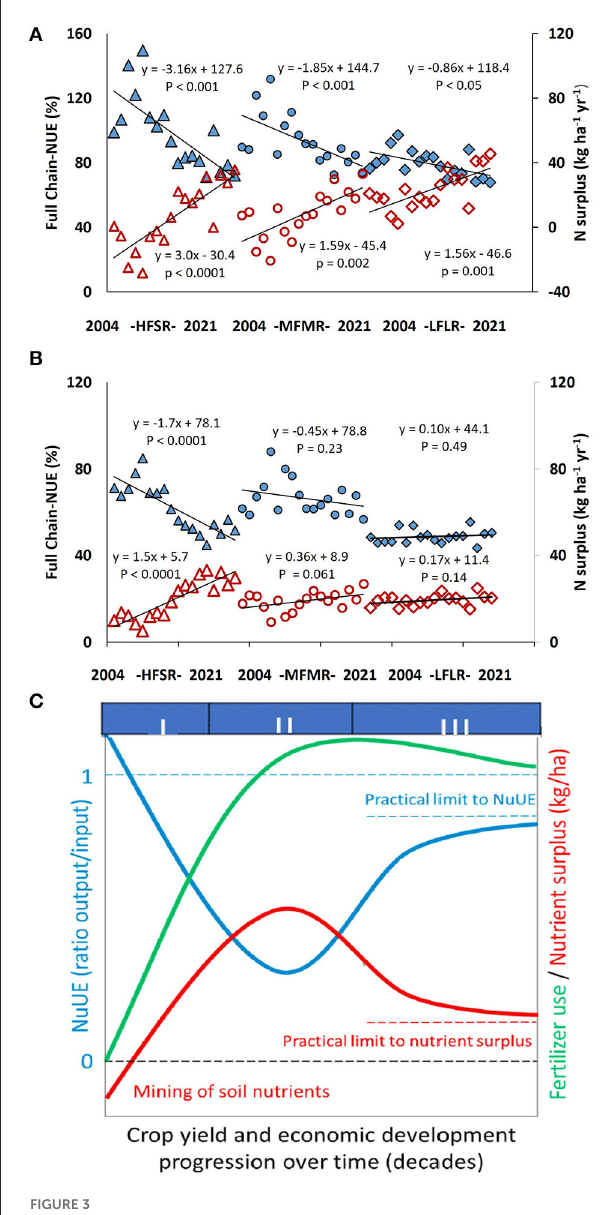
FIGURE3 (A) Rice and (B) system N surplus and N use efficiency in 2004–2005 to 2021–2022 growing seasons. Triangles, HFSR (high fertility and short rotation); circles, MFMR (medium fertility and medium length rotation); rhombuses, LFLR (low to medium fertility and long rotation). Blue symbols, system (full chain) NUE and red symbols, system N surplus. (C) Generalized development pathway for N use